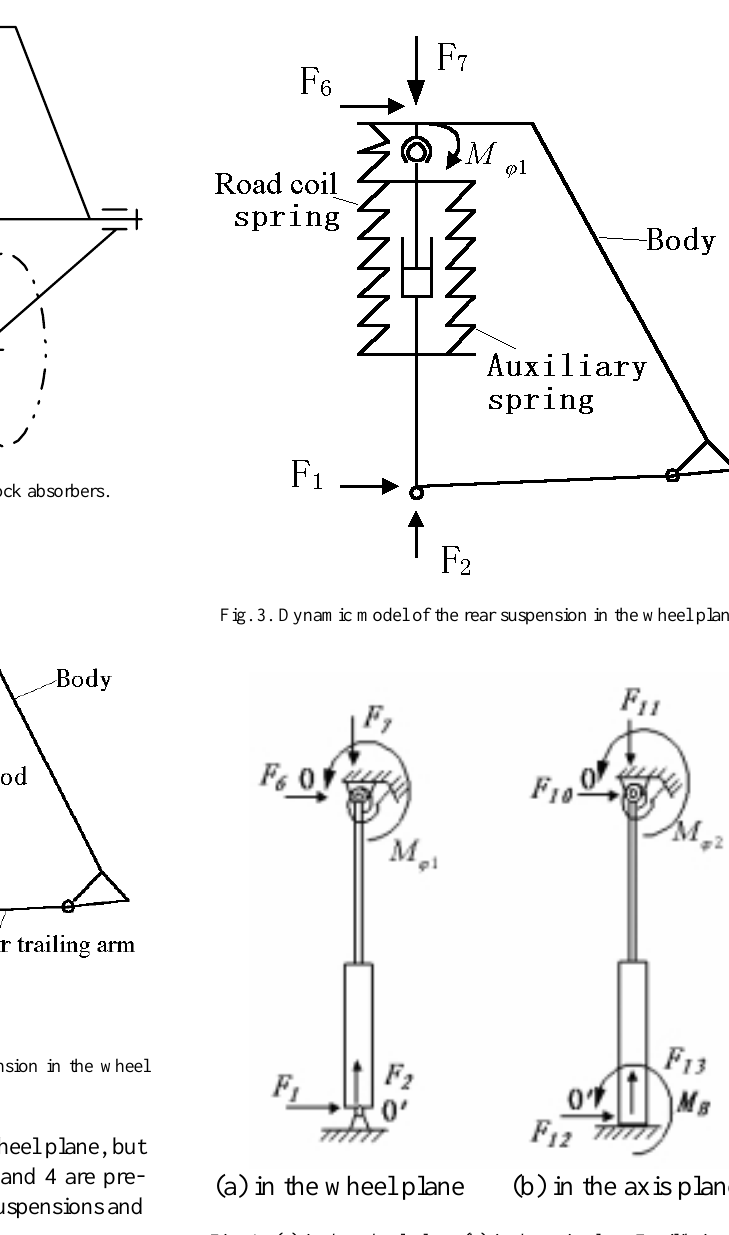
Fig. 4. (a) in the wheel plane (b) in the axis plane Equilibrium of forces on the rear